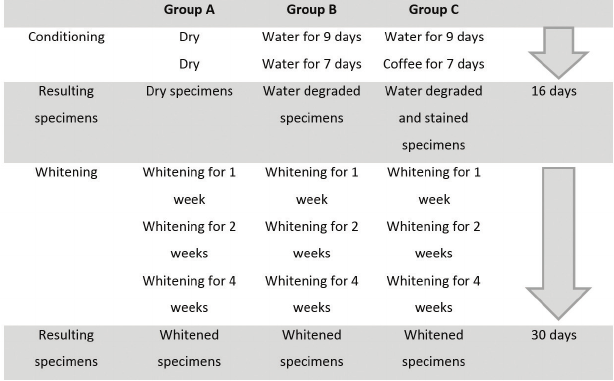
Fig.1. Study flow diagram involving conditioning and whitening procedures and